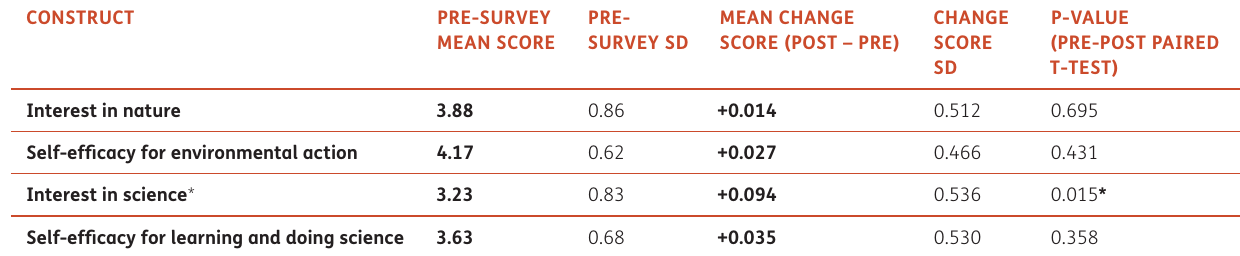
Table 1 Overall baseline and change